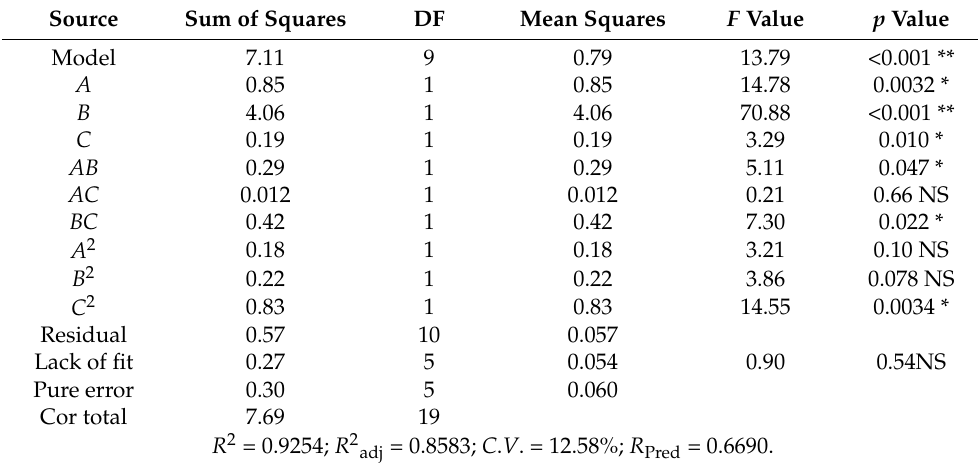
Table 6. Regression variance analysis for the impurities